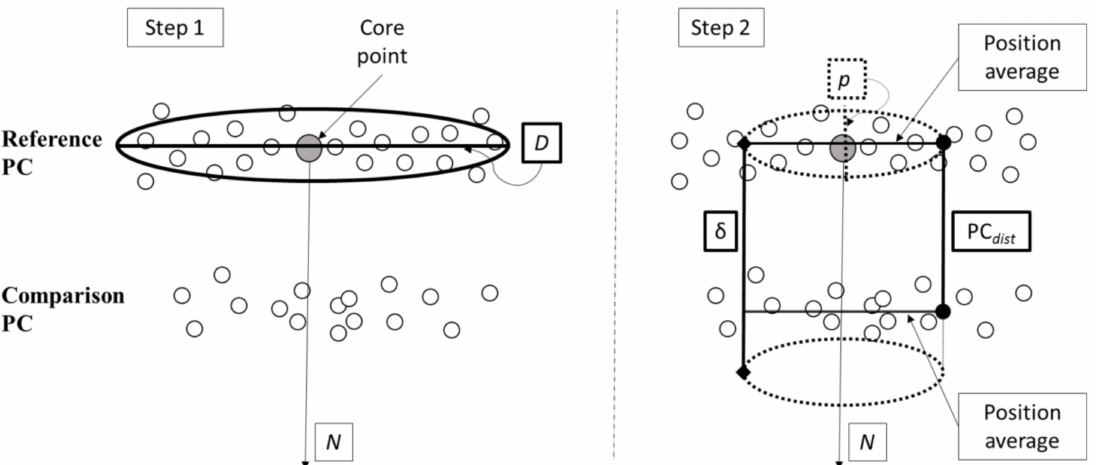
Figure 5. Simplified illustration of the Multiscale Model-to-Model Cloud Comparison algorithm. In step 1, the surface normal ( N ) is determined by fitting a plane to the points (open circles) within a user-defined diameter, D , from each core point (grey circle). In step 2, a cylinder with diameter p is centered on the core point and projected along the direction represented by N . The algorithm projects the cylinder both above and below the core point, but the figure shows the projection in a single direction for simplification. The cylinder length is the maximum search distance ( δ ) and this defines a space where matching points in both point clouds are averaged and differenced to calculate the point cloud distance (PC dist ). The open circles represent cloud points. The grey circles represent core points. Adapted from Lague et al.